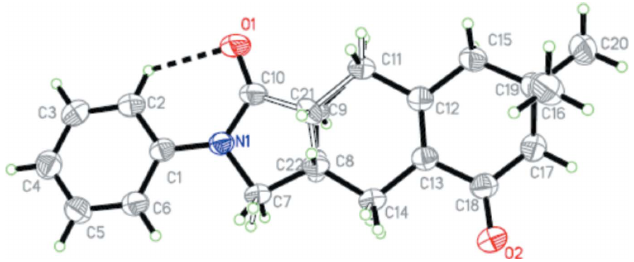
Table 1 Hydrogen-bond geometry (A˚ , (cid:3) ).